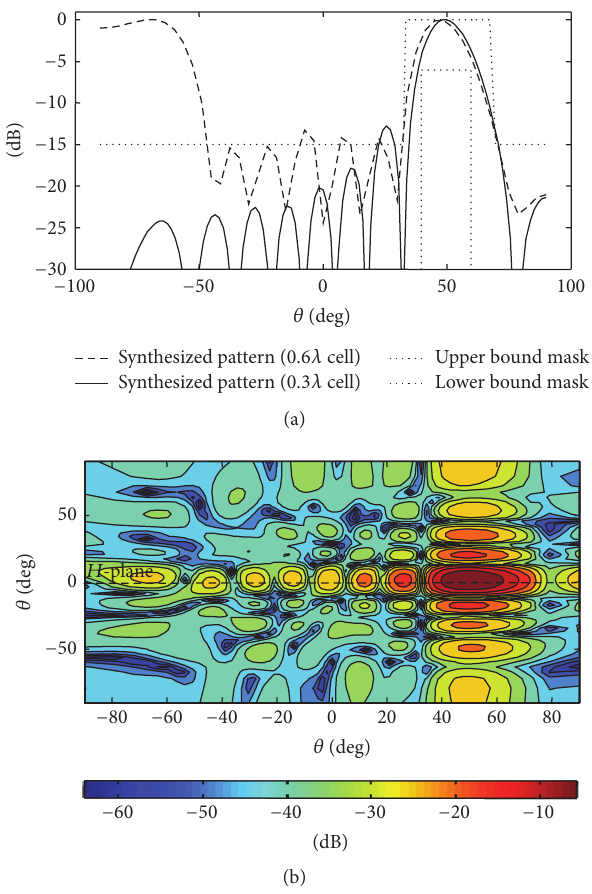
Figure 21: Design #1 : (a) synthesized 𝐻 -plane array factor; (b) synthesized 𝐸 -field contour